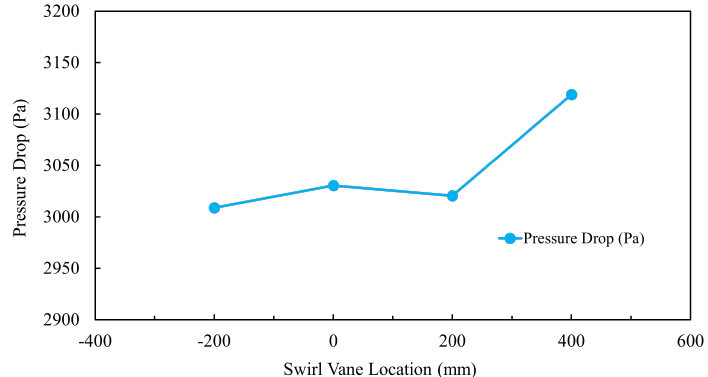
Figure 18. Pressure drop between the inlet and outlet at various vane locations.